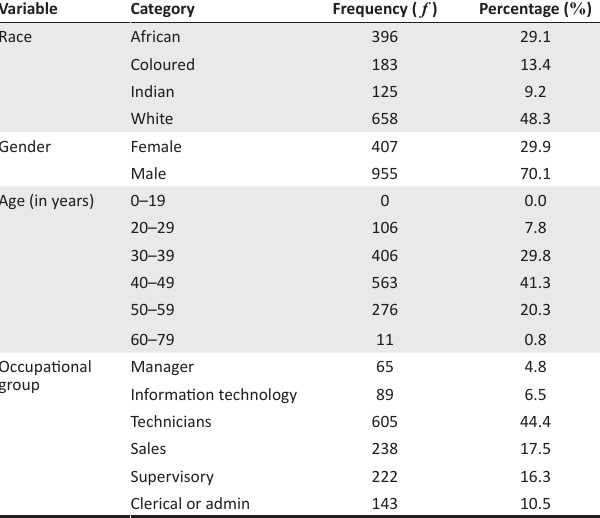
TABLE 1: Biographical and demographic data of respondents. Variable